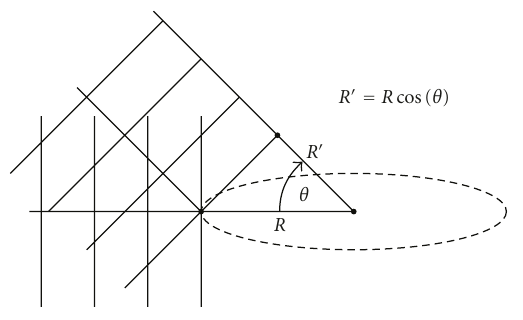
Figure 2: Geometry of plane waves incident on a circular array in the horizontal plane.